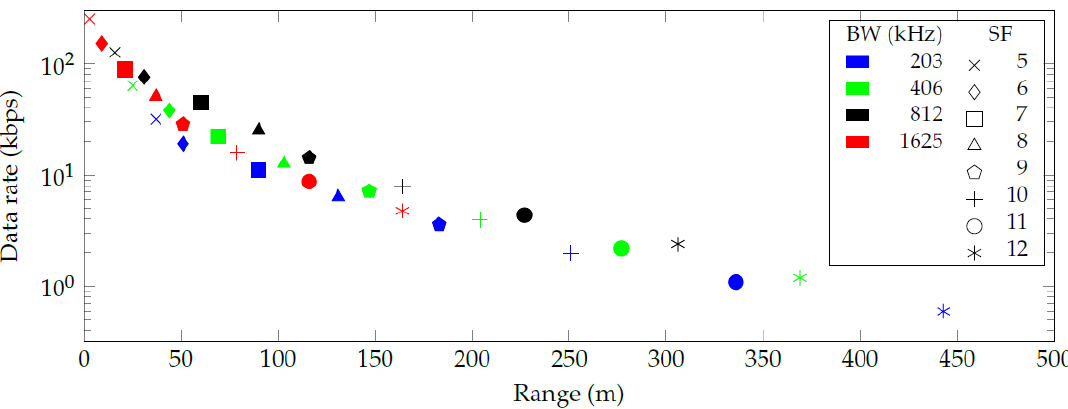
Figure 4. Communication range and data rate for every combination of spreading factor (SF) and bandwidth (BW) in an urban environment.